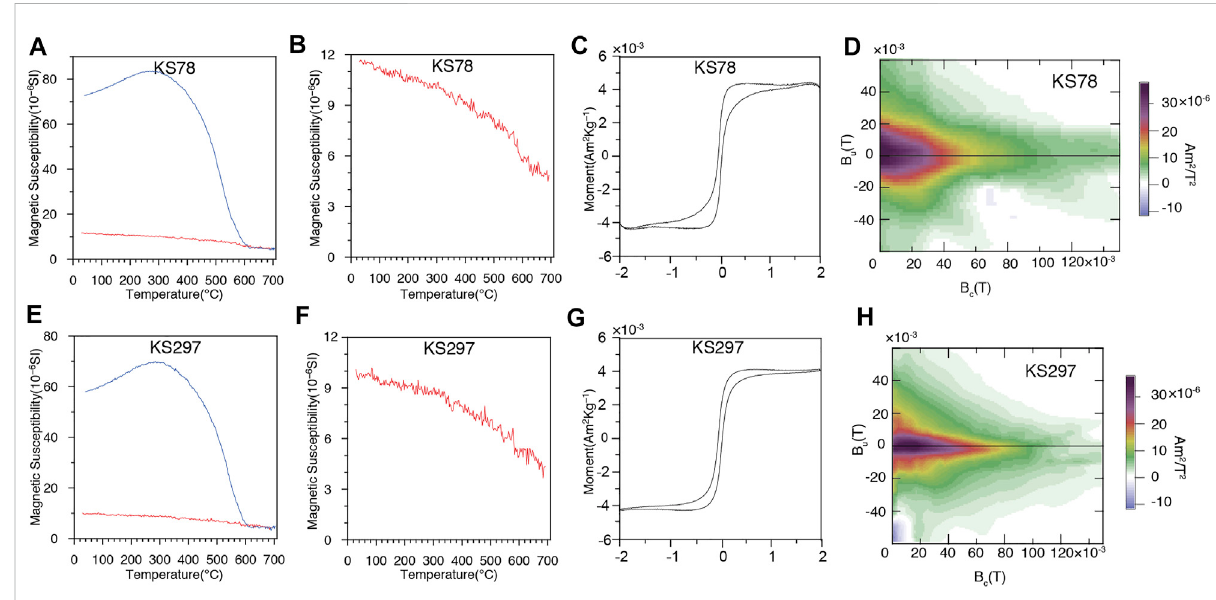
FIGURE 4 Rockmagnetismforrepresentativespecimens. (A) , (B) , (E) ,and (F) ,thermomagneticsusceptibilitycurves. (C) and (G) ,magnetichysteresisloops. (D) and (H) , fi rst-order reversal curves